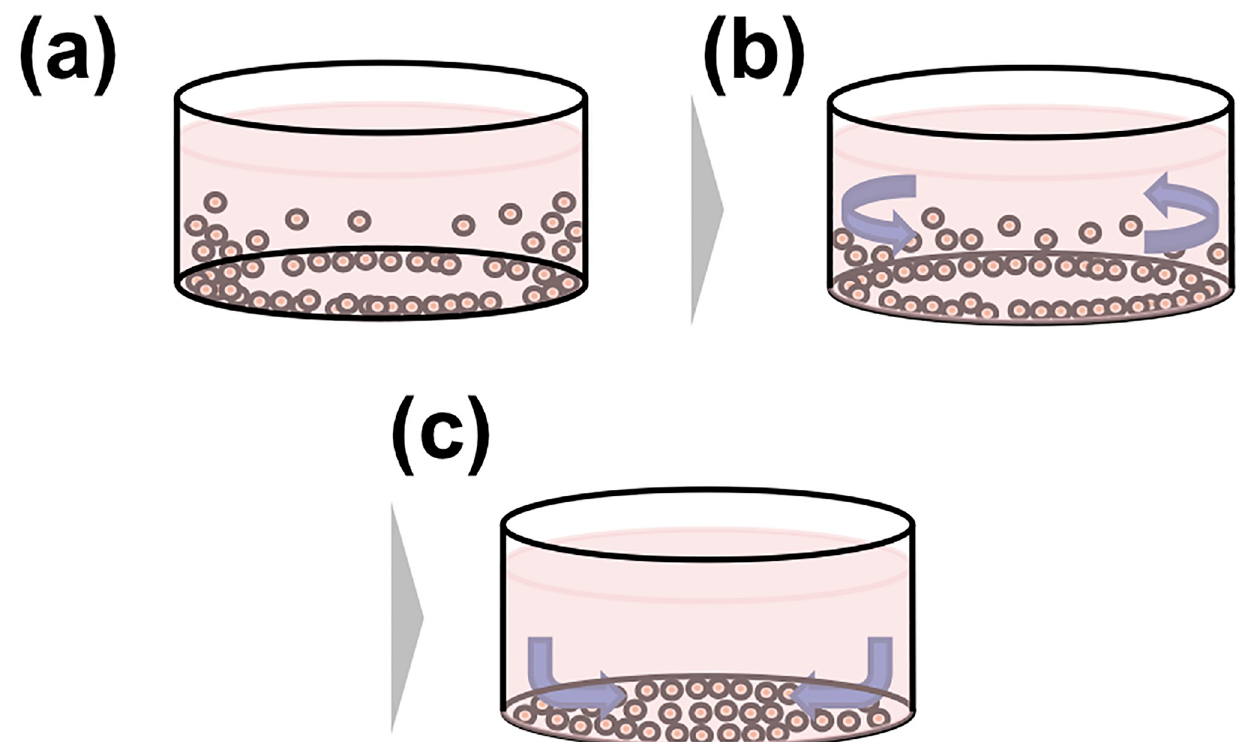
Fig 1. Concept of the cell density homogenization method using Ekman transportation. (a) Schematic diagram of the initial cell distribution after seeding with a pipette. The cell density around the edge of the dish is higher than that at the center of the dish. (b) A swirl flow is induced by rotating the dish along a circular orbit. (c) Due to the swirl flow, a secondary flow directed toward the center is induced in the cell suspension. The cells accumulated around the edge are moved to the center of the